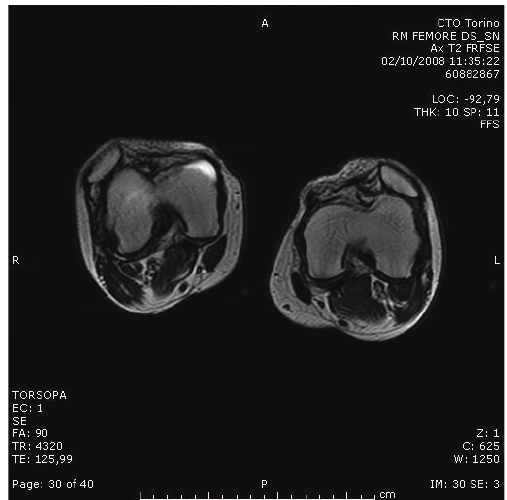
Figure 6: Significative MRI image of the knees (extended), showing the dislocation of the patellae, the severe hypoplasia of the medial side of the femoral quadriceps, and the pseudojoint of the lateral